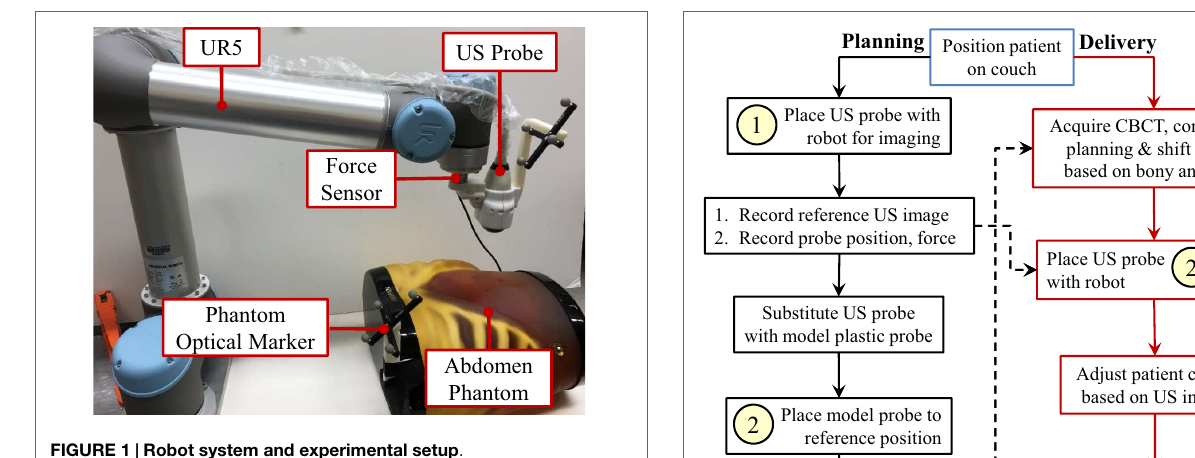
FIGURE 1 | Robot system and experimental setup .